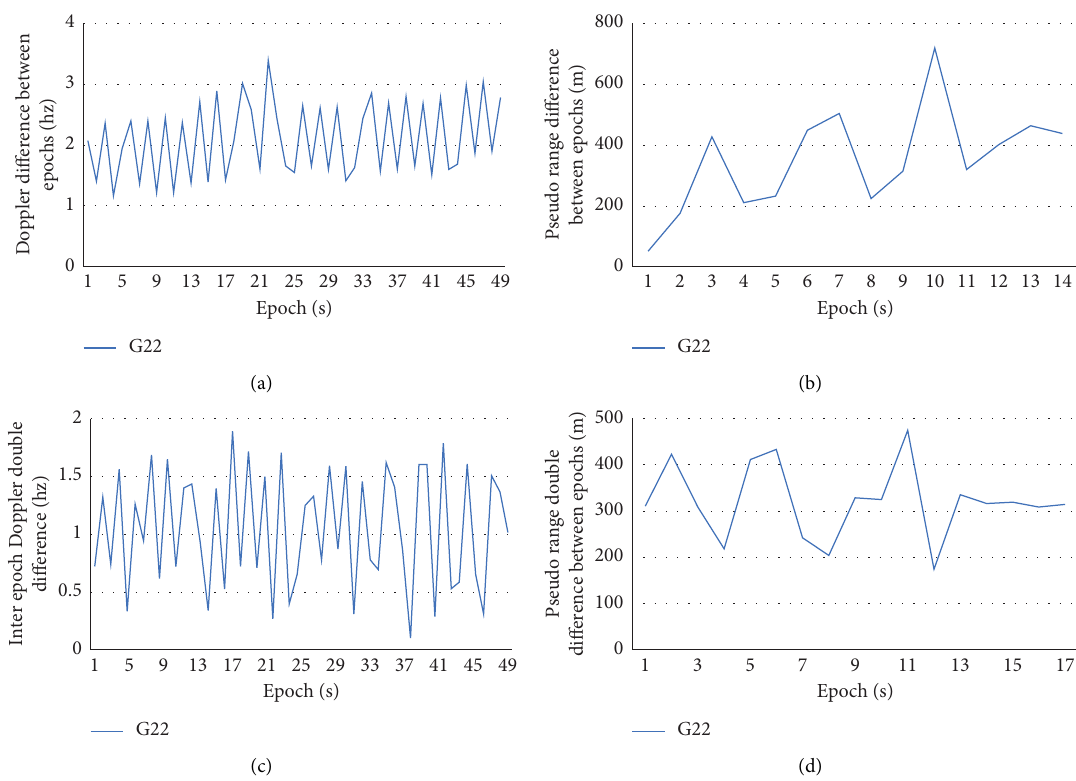
Figure 6: Doppler diference and pseudorange diference between ephemeris elements of the G22 satellite. (a) Doppler single diference. (b) Pseudorange single diference. (c) Doppler double diference. (d) Pseudorange double